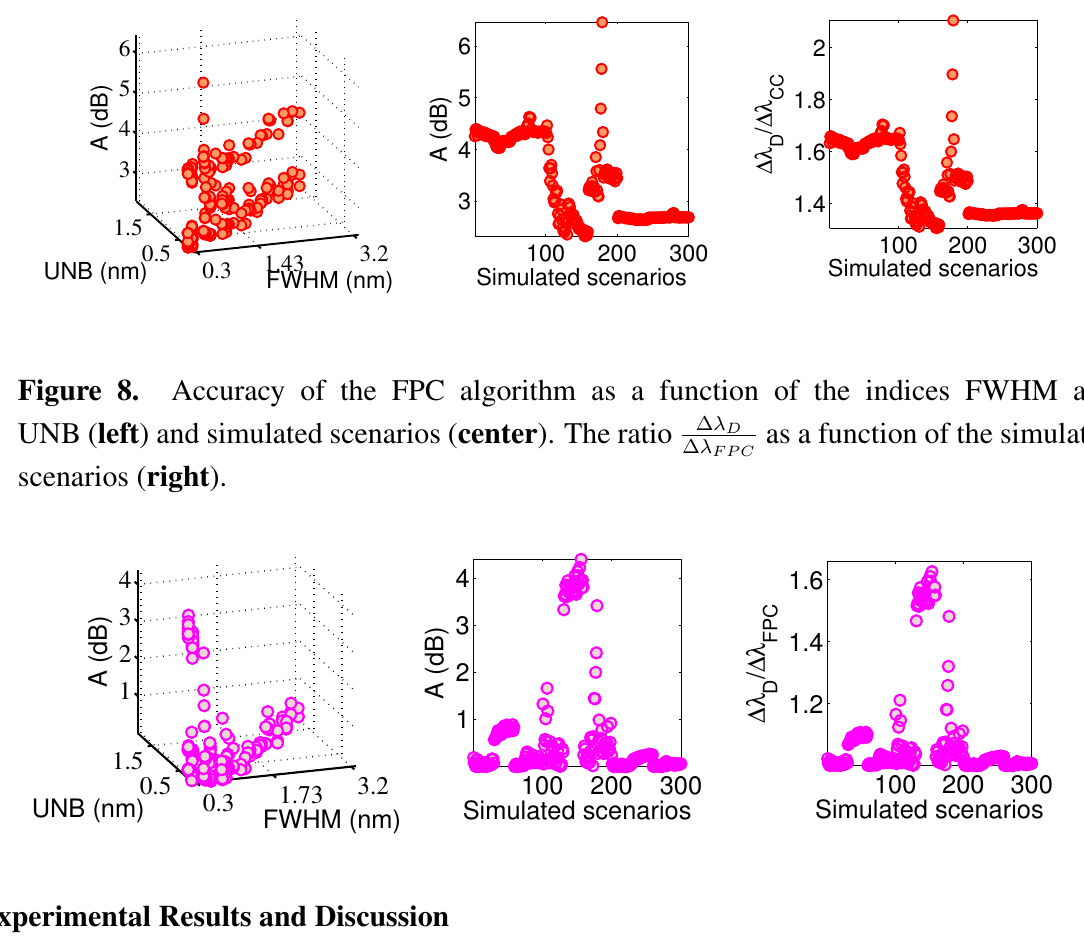
Figure 7. Accuracy of the CC algorithm as a function of the indices FWHM and UNB ( left ) and simulated scenarios ( center ). The ratio ∆ λ D scenarios ( right ).